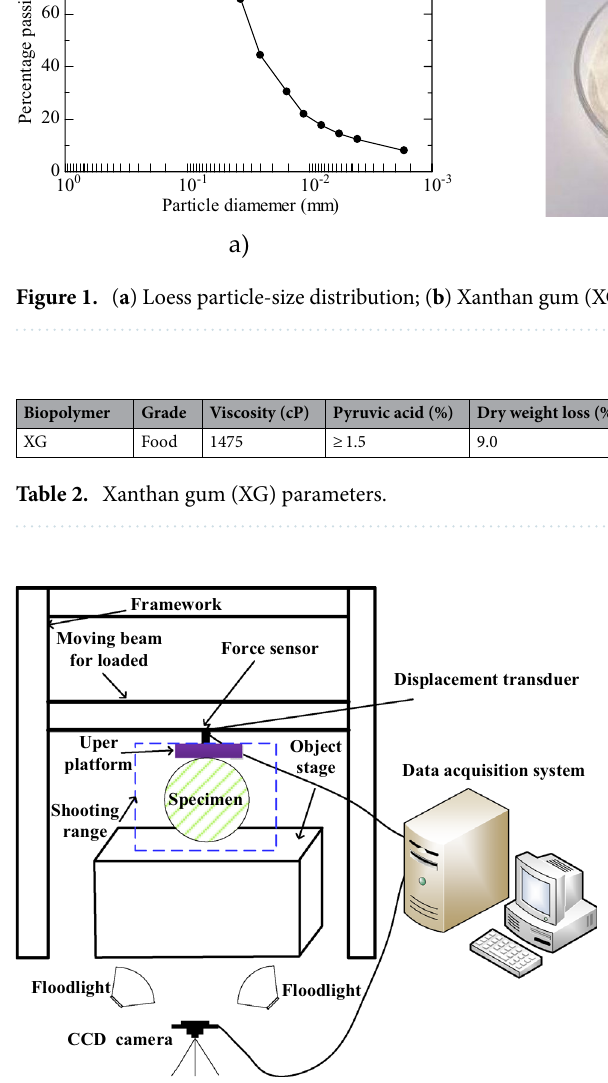
Figure 2. Schematic diagram of splitting tension